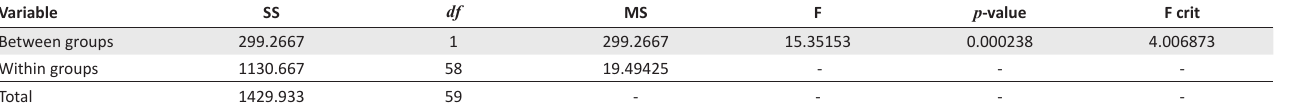
TABLE 3: Statistical pre- and post-test results. Variable